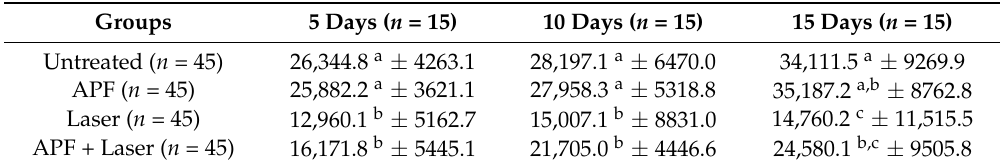
Table 1. Means ± standard deviation (µm 2 ) of area of dentin wear according to the treatments and duration of erosive/abrasive cycling. Treatments followed by distinct superscript letters differ statistically by the Tukey test ( p < 0.05).